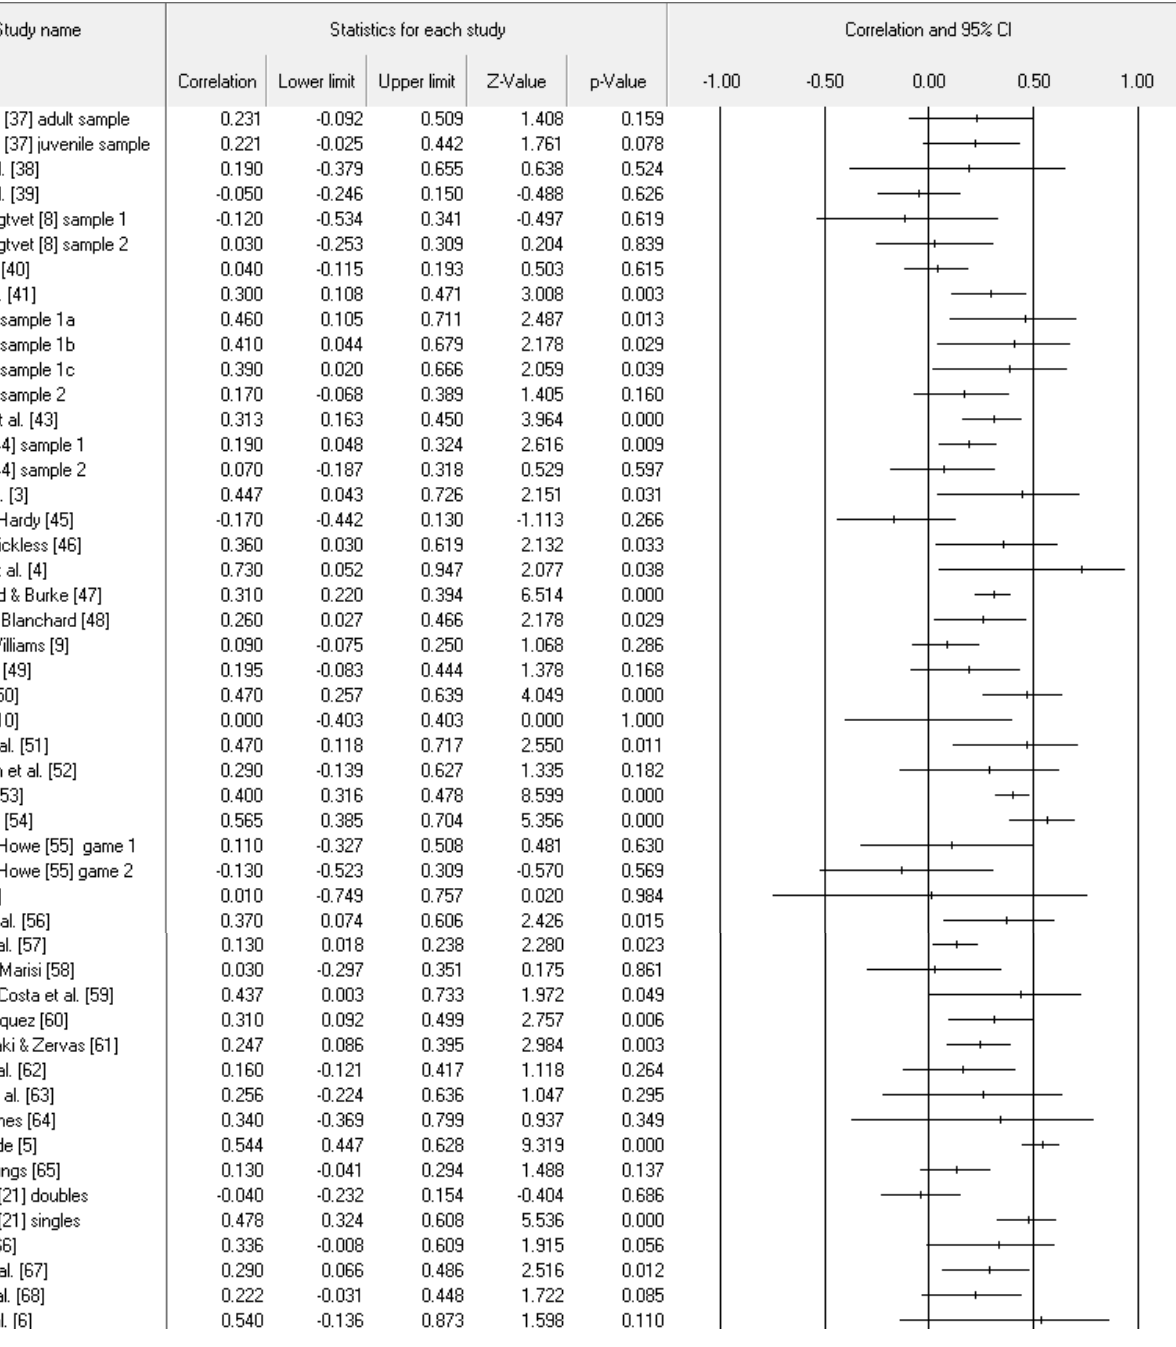
Figure 2. Study effect size statistics expressed as correlations and corresponding forest plot.